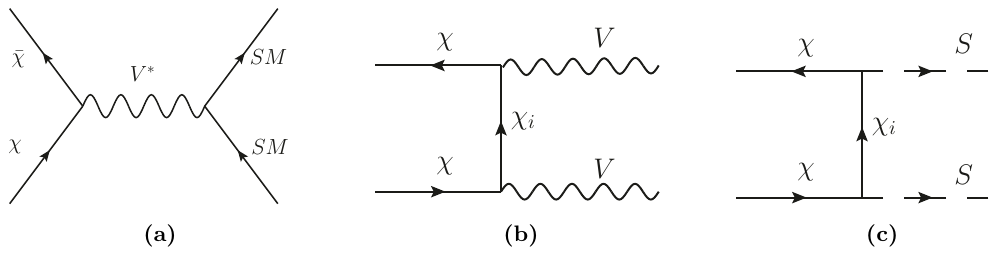
Figure 1. Dominant DM annihilation channels (note that (cid:31) can be either (cid:31) 1 or (cid:31) 2 depending whether or not coannihilation is relevant). The processes are (a) S-channel annihilation through an o(cid:11)-shell dark photon, (b) Thermally-induced forbidden annihilation into dark photons, (c) Secluded annihilation into two dark Higgs